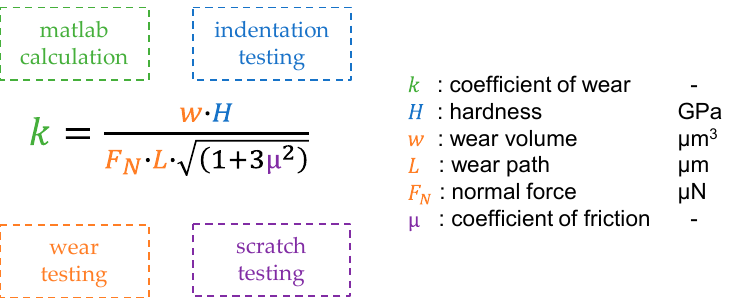
Figure 7. Calculation of the coefficient of wear with the assignment of the parameters to the test methods.